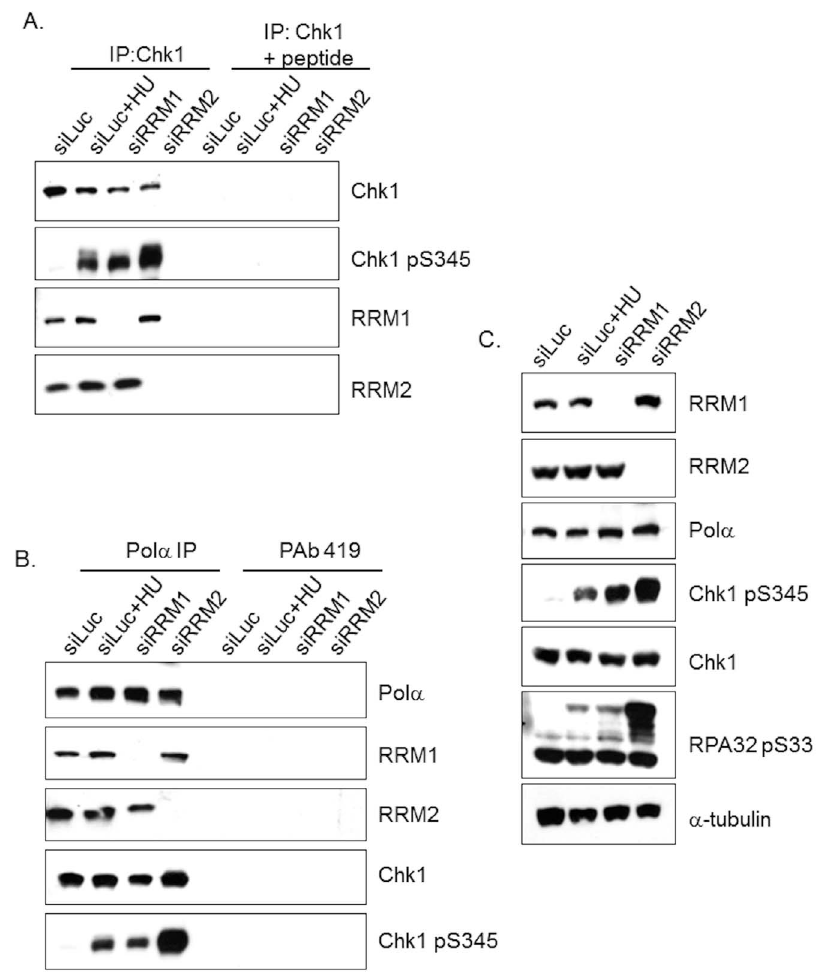
Figure 4. RRM1 and RRM2 subunits of Ribonucleotide reductase interact with Chk1 and Pol a . (a) At 30 h after siRNA transfections of the luciferase, RRM1, and RRM2 siRNA duplexes, extracts were prepared for immunoprecipitations. Cells transfected with Luciferase were incubated with 1 mM HU for 30 min. Chk1 was immunoprecipitated from luciferase (positive control), Luciferase + HU, RRM1, and RRM2 depleted cells with Chk1 antibodies (MAb58D7) cross-linked to protein A and were immunoblotted as indicated. Chk1 immunoprecipitations were peptide blocked as a negative control. (b) Pol a was immunoprecipitated from luciferase (positive control), luciferase + HU, RRM1, and RRM2 depleted cells depleted cells with Pol a antibody (SJK132-20) cross-linked to protein G and Western blots were immunoblotted as indicated. (c) Whole cell extracts were immunoblotted as indicated.